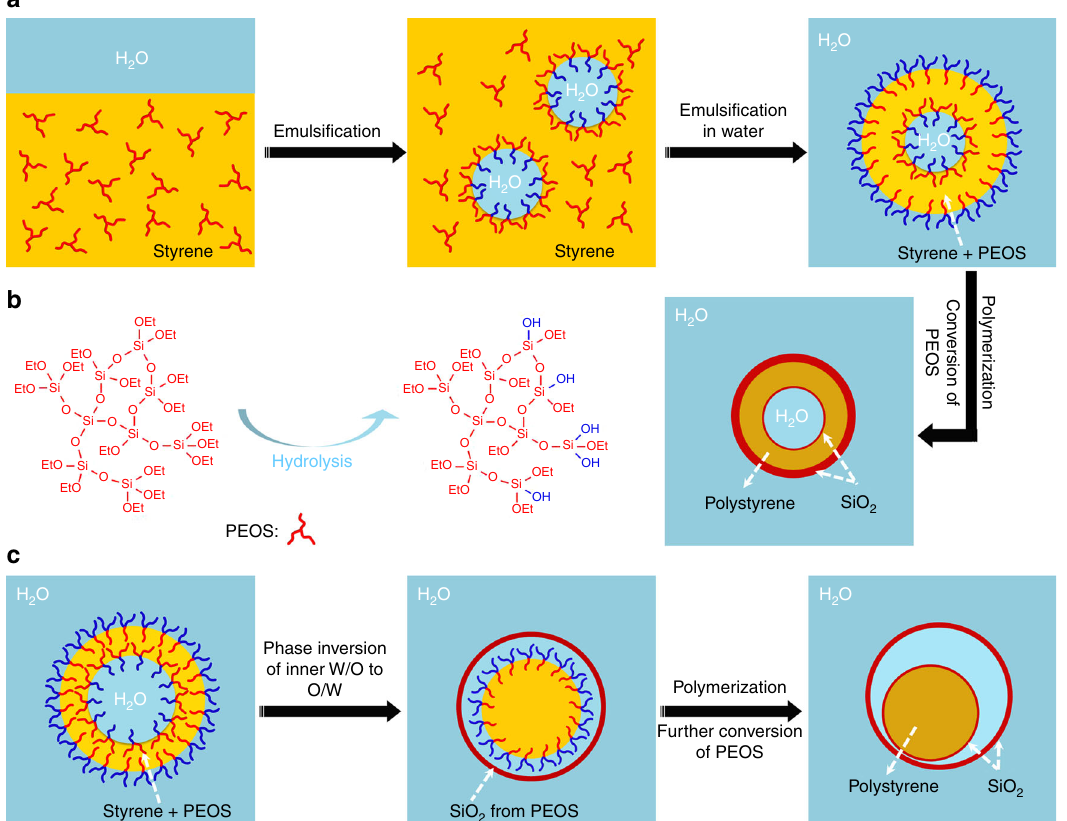
Fig. 5 Nanocapsules and nanorattles. a A low fraction of internal water phase results in H 2 O@SiO 2 @polystyrene@SiO 2 nanocapsules and c polystyrene@SiO 2 @H 2 O@SiO 2 nanorattles are obtained with a relatively high fraction of internal water phase. b Hydrolysis-induced amphiphilicity of